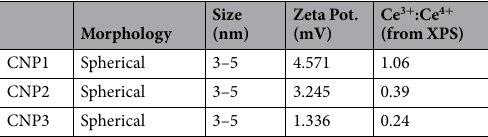
Table 1. Ceria Nanoparticle